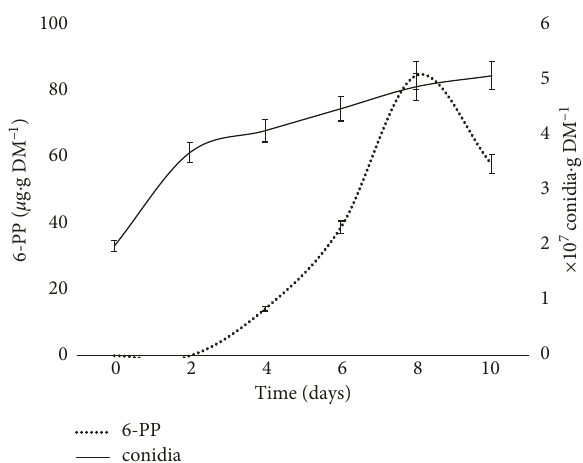
Figure 2: Evolution of conidia and 6-PP production in the solid medium, during the culture of T. asperellum G7 on solid